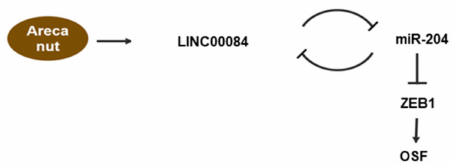
Figure 7. Schematic diagram of the role of LINC00084/miR-204/ZEB1 axis in OSF progression. Arecoline, a major alkaloid from the areca nut, activates the transdifferentiation of buccal mucosal fibroblasts (BMF) into myofibroblasts (including the increased phenotypes and fibrosis markers) via upregulation of LINC00084. LINC00084 could modulate the expression of ZEB1 by acting as a competing endogenous RNA (ceRNA) of